Question: Name the type of graph shown.
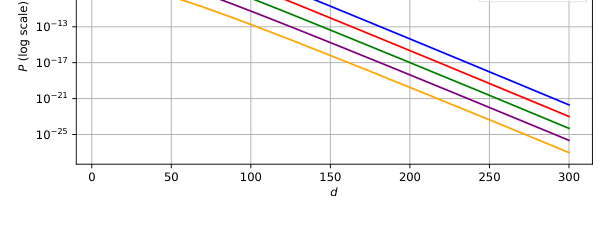
Answer: line